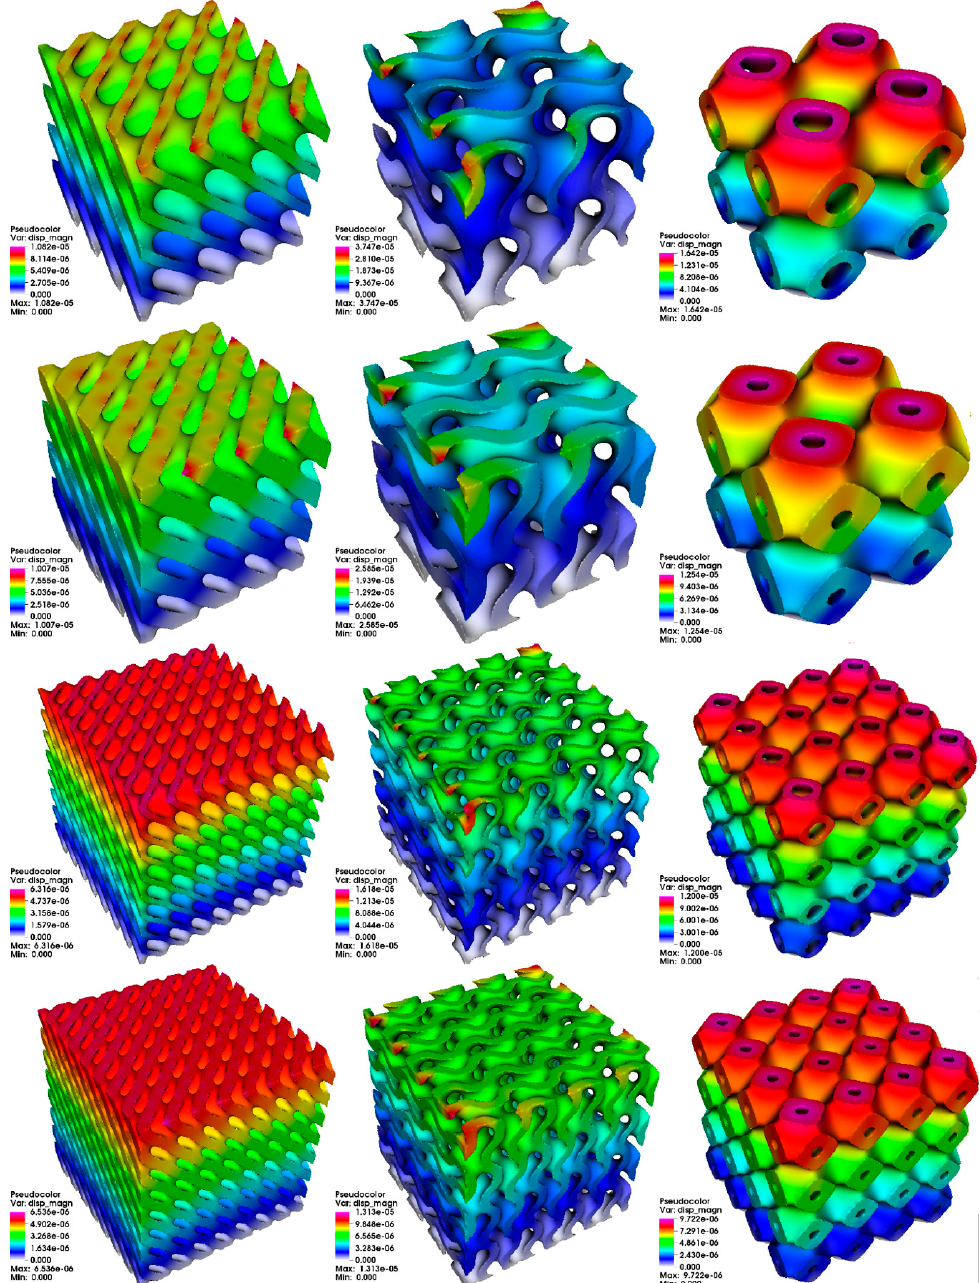
Figure 3. The results of total displacement from stress analysis. Columns from left to right: diamond (D) surface, gyroid (G) surface, primitive (P) surface. Rows from top to bottom: 2 cells, relative thickness δ = 0.125; 2 cells, relative thickness δ = 0.2; 4 cells, relative thickness δ = 0.125; 4 cells, relative thickness δ = 0.2.